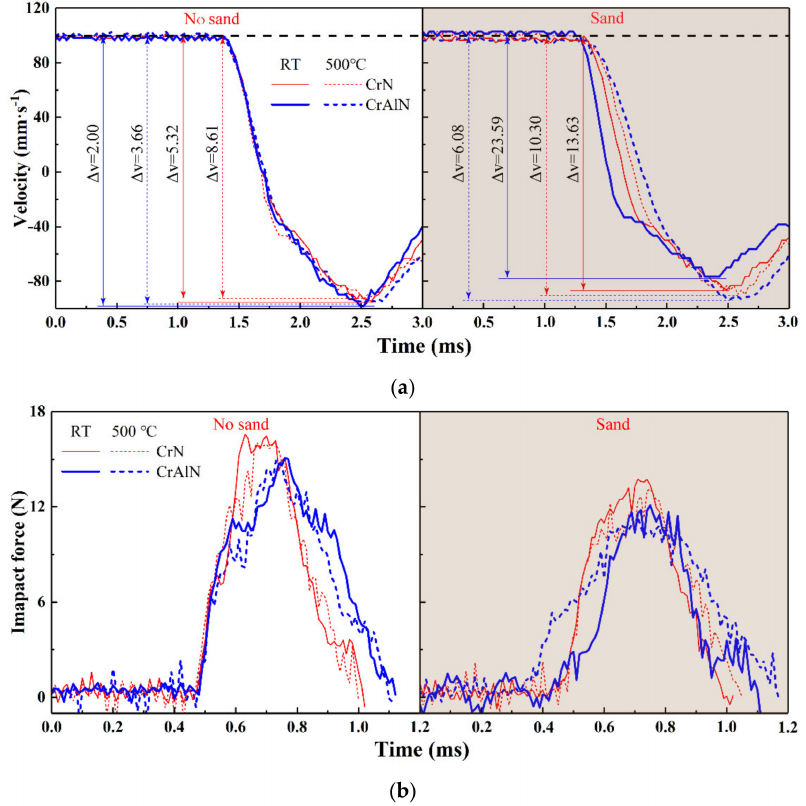
Figure 5. Impact kinetic response on CrN and CrAlN coatings. ( a ) Impact velocity vs. time, and ( b ) impact force vs. time.